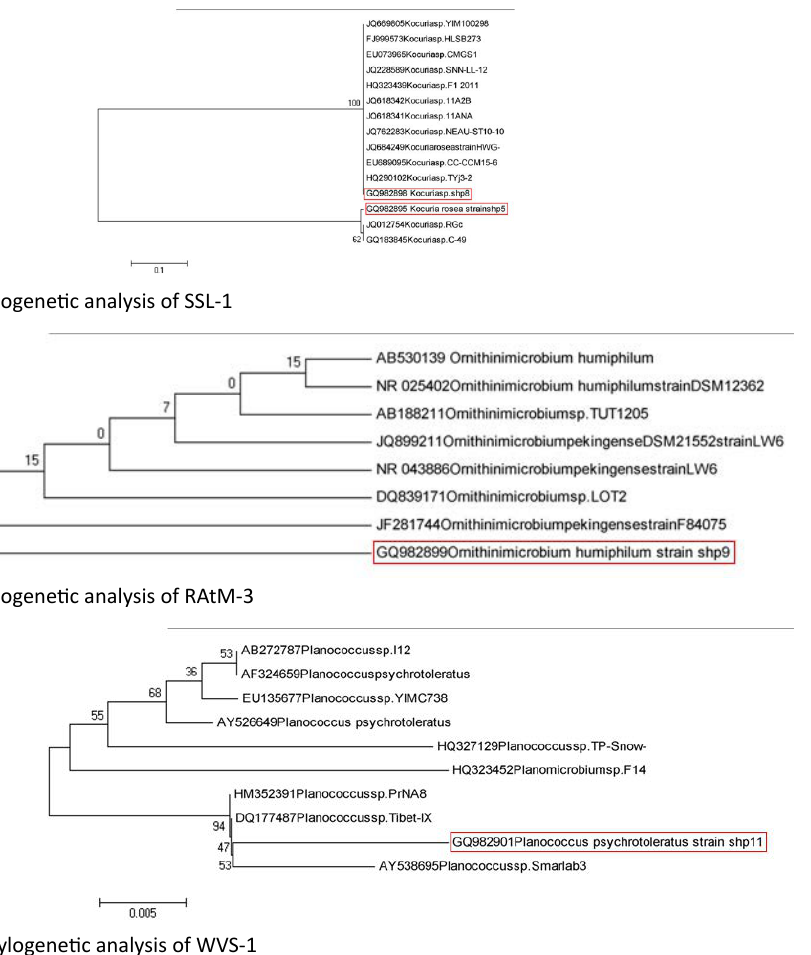
Fig. 10. Phylogenetic analysis of